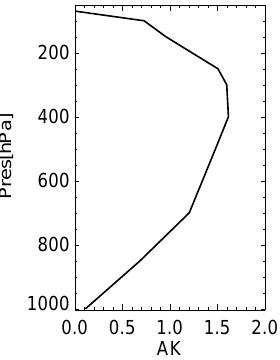
Fig. 1. Mean averaging kernel for IASI CO total columns over west- ern Russia for 20 July–15 August 2010.